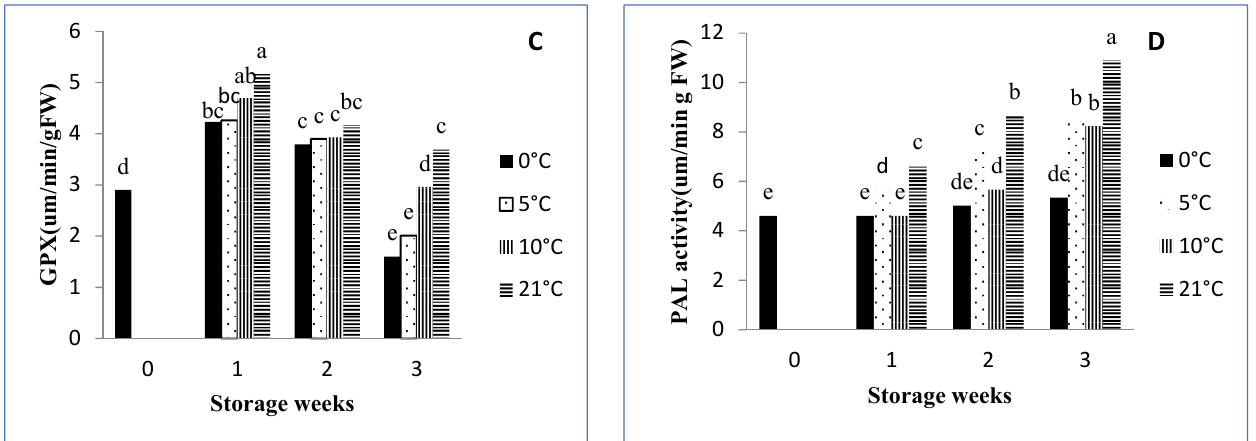
Figure 4. Effects of different storage temperatures on catalase ( A ), polyphenol oxidase ( B ), guaiacol peroxidase ( C ), and phenylalanine ammonia-lyase ( D ) activities of cornelian cherry fruits treated with 1% chitosan. Different letters on bars indicate significant differences among storage temperatures at p < 0.05 by Duncan’s test.